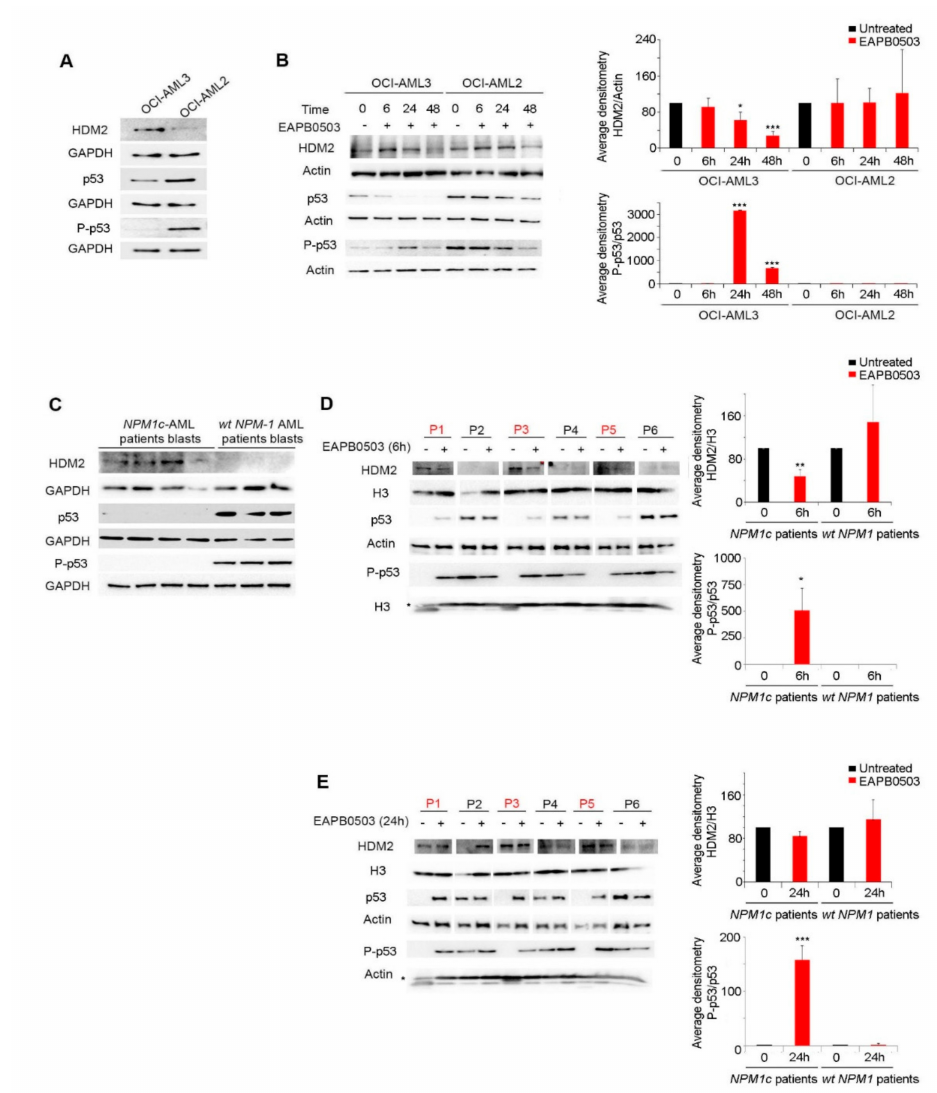
Figure 2. EAPB0503 actives p 53 signaling pathway and dowregulates its ubiquitin ligase HDM2. ( A ) Western blot analysis showing basal levels of HDM2, p 53, P - p 53, GAPDH and actin in untreated OCI-AML3 and OCI-AML2 cells. ( B ) Western blot analysis of HDM2, p 53, P - p 53, and actin in EAPB0503 treated OCI-AML3 and OCI-AML2 cells for 6, 24 and 48 h. Histograms represent the densitometries of HDM2/Actin and P - p 53/ p 53 ratio of 3 independent experiments. ( C ) Western blot analysis showing the basal expression levels of HDM2, p 53 and P - p 53 with respect to GAPDH in blasts from NPM1c and wt -NPM1 AML patients. Western blot analysis shows the expression